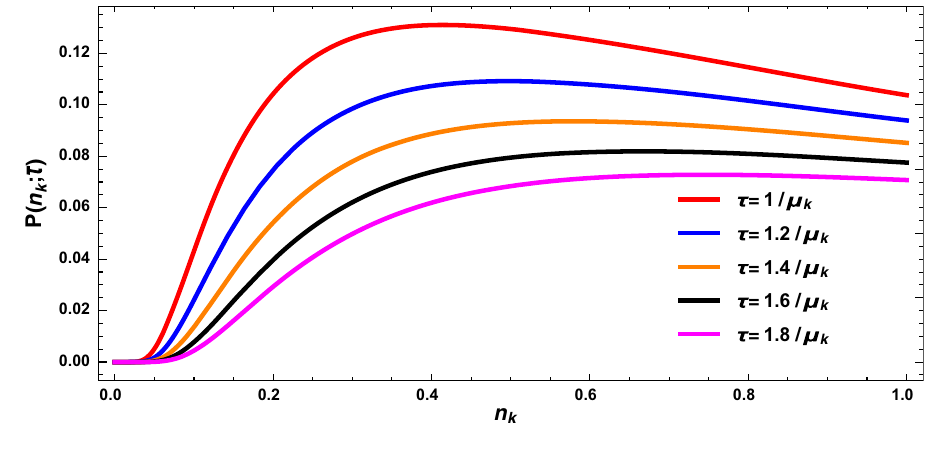
Fig. 37 Evolution of the probability density function with respect to the occupation number per mode n k , for a fixed time in the limit n k (cid:5)